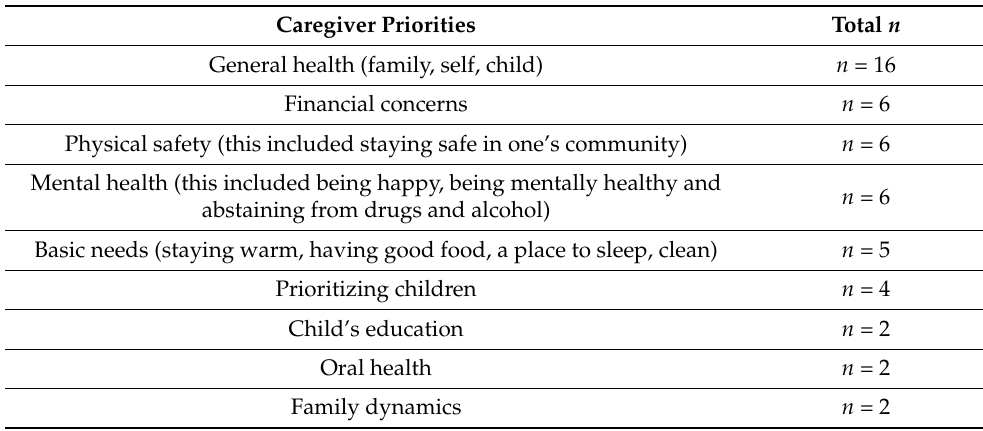
Table 2. Caregiver priorities.